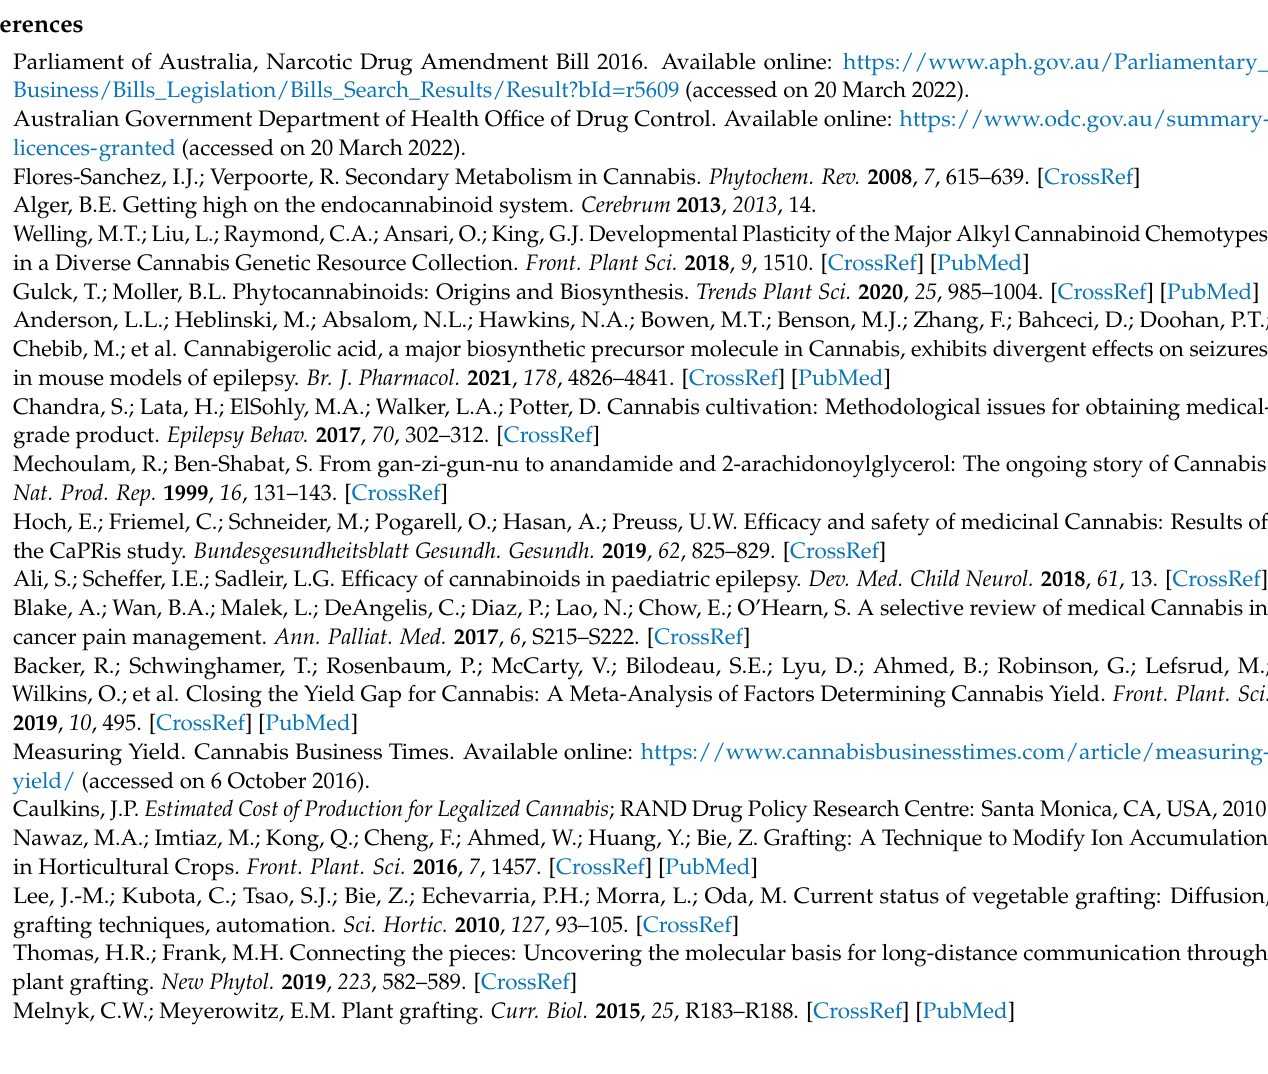
Cannabis. Supplementary Figure S1: Spearman’s rank correlation between rootstock mature plant height and grafted CBD1 scion